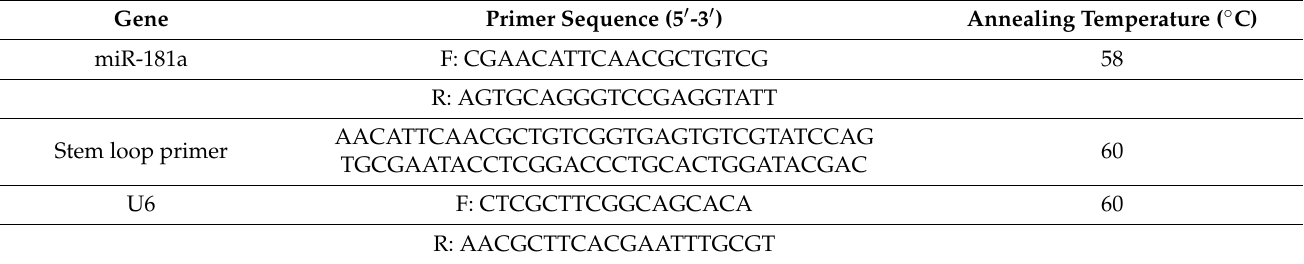
Table 1. MiRNA primers used for qRT-PCR.